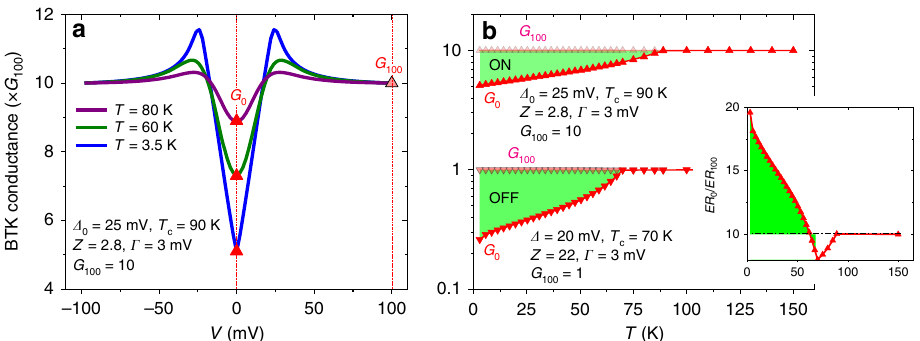
Fig. 5 BTK modelling of the temperature dependent quasiparticle tunnel electro-resistance. a Example of the BTK conductance vs . bias at different temperatures for a set of parameters (indicated in the legend) that correspond to the ON state. G 0 and G 100 are respectively indicated by the dark/light triangles. b G 0 ( T ) (dark triangles) and G 100 ( T ) (light triangles) calculated in the ON and OFF state using the BTK parameters indicated in the legend. Notice that G 0 ( T ) gradually drops below G 100 ( T ) as temperature is decreased beyond T C , which is highlighted by the green regions. The departure is more pronounced in the OFF state than in the ON state. The inset shows the ratio ER 0 / ER 100 as deduced from the calculations shown in the main panel. Notice the steady increase below the critical temperature in the OFF state ( T C = 70 K), highlighted by the green region.